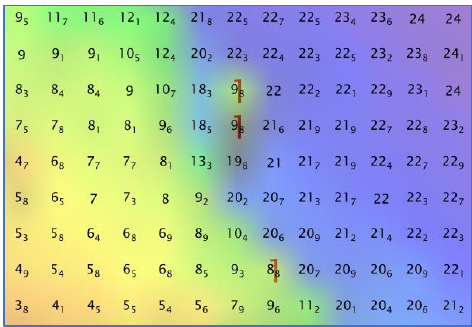
Figure 3. Example of potential fliers detected by the Laplacian Operator algorithm (marked with an orange 1). The black values are depth values in meters from the evaluated grid; when shown, the sub-index represents decimeters. The algorithm calculates the Laplacian operator as a measure of curvature by summing the depth gradients of the adjacent nodes. A cell is flagged as a potential flier when the resulting absolute value is greater than the search height.